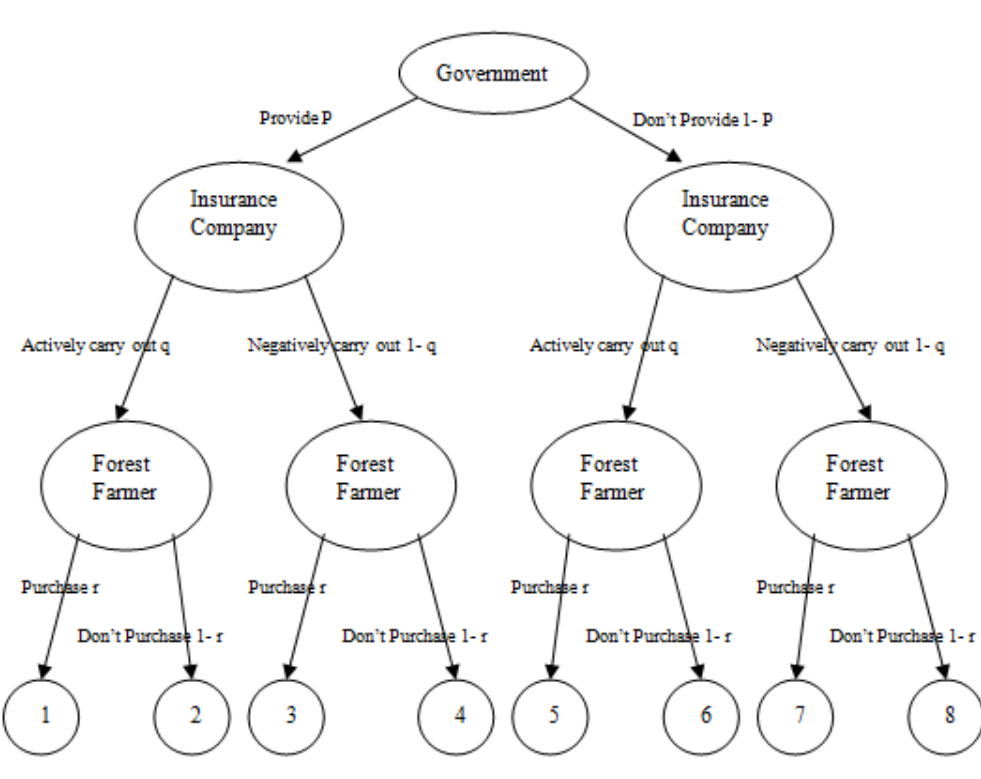
Figure 1. Game tree of